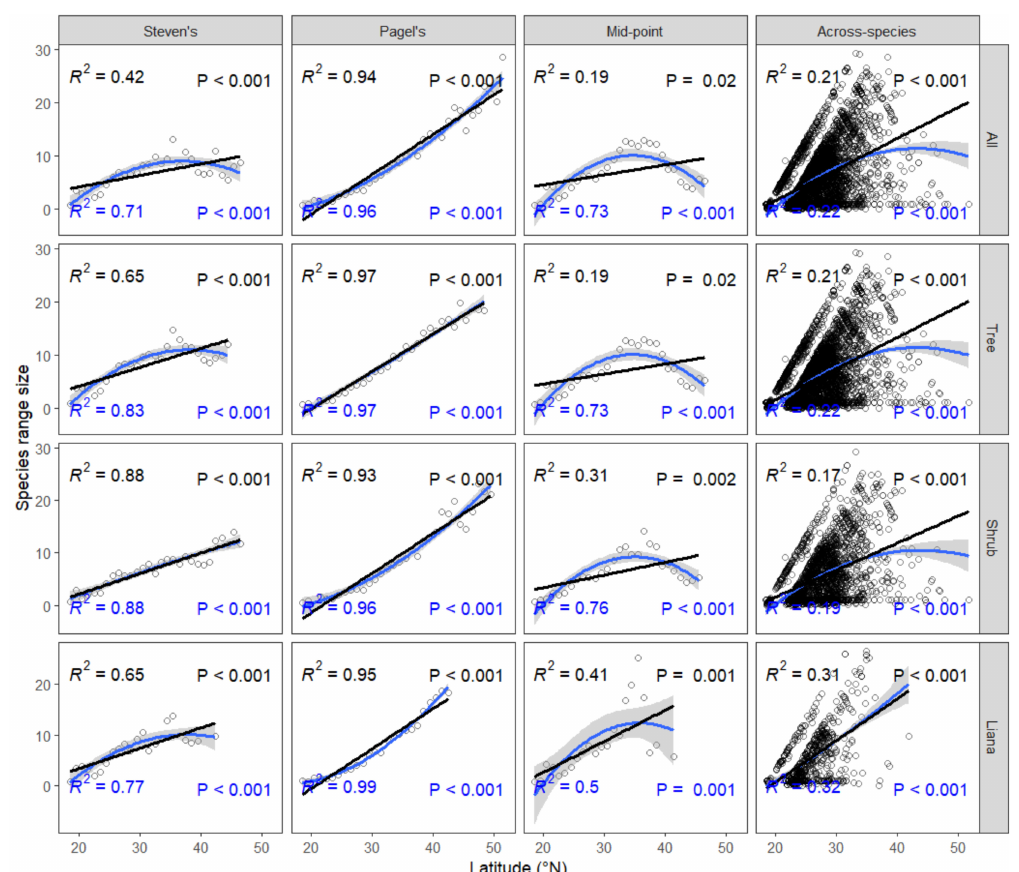
Figure 1. Species range size versus latitude for three growth forms of Chinese endemic woody seed plants, and their tests for Rapoport e ff ects by Steven’s method, Pagel’s method, mid-point method, and across-species method. Black solid lines represented fitted relationships between species range size and latitude. They were all positive except in mid-point method. Blue lines and shades were fitted by parabolic regressions with 95% confidence intervals. Groups included all species, trees, shrubs, and